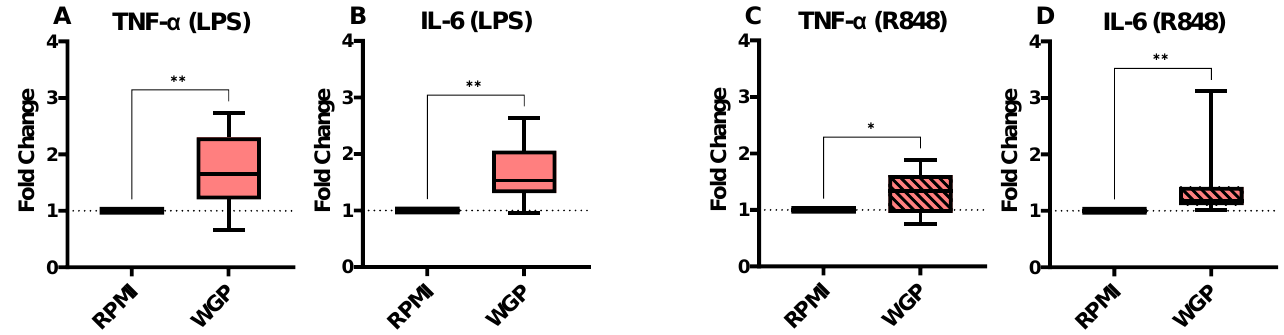
Figure 4. The fold changes in TNF- α ( A ) and IL-6 ( B ) production of the cells trained with WGP and stimulated with LPS in comparison to the untrained control. The TNF- α ( C ) and IL-6 ( D ) production fold changes for WGP-trained monocytes after stimulation with R848. The average (range) of cytokines in the RPMI controls of all 8 donors tested were 1805 (719–4825 pg/mL), 3181 (1044–7232 pg/mL), 3592 (1839–7434 pg/mL), and 9047 (3732–14230 pg/mL) for conditions A to D, respectively. The boxes represent 50% of the data, and the line is the median value where upper and lower whiskers present the upper and lower 25% of the data, respectively. The significance of differences is shown as p -value < 0.05 (*) and < 0.01 (**). Similarly, IL-6 and TNF- α production levels were determined in the supernatants of restimulated monocytes that were trained with RSV preF protein only (50 µ g/mL), bIgG only (10 µ g/mL), or the ICs of the combination of these. The cells trained with bIgG: